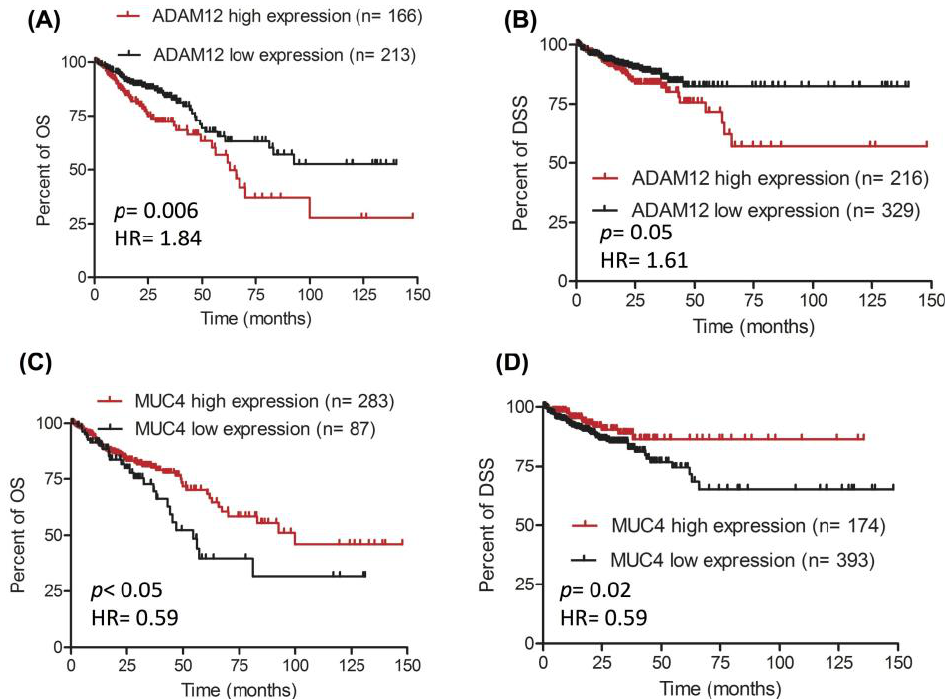
Figure 2. Survival curves of the prognostic value of ADAM12 and MUC4 in colorectal adenocarcinoma. Two TCGA transcriptomics datasets generated from patients with colorectal adenocarcinoma were used to evaluate the prognostic potential of ADAM12 and MUC4 . A high expression of ADAM12 predicted a shorter OS ( A ) colorectal adenocarcinoma TCGA Firehose Legacy dataset) and a shorter DSS ( B ) colorectal adenocarcinoma TCGA PanCancer Atlas dataset). A low expression of MUC4 predicted a shorter OS ( C ) colorectal adenocarcinoma TCGA Firehose Legacy dataset) and a shorter DSS ( D ) colorectal adenocarcinoma TCGA PanCancer Atlas dataset). OS: overall survival; DSS: disease-specific survival.